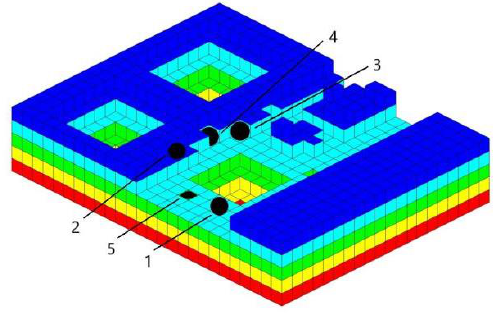
Figure 10. Illustration of the location of Pb 2+ adsorption on the dolomite surface: 1, on the face; 2, on the step; 3, kinks; 4, within the step; 5, within the cavity.